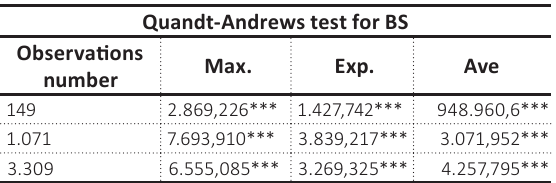
Table 2. Test for unknown structural breaks